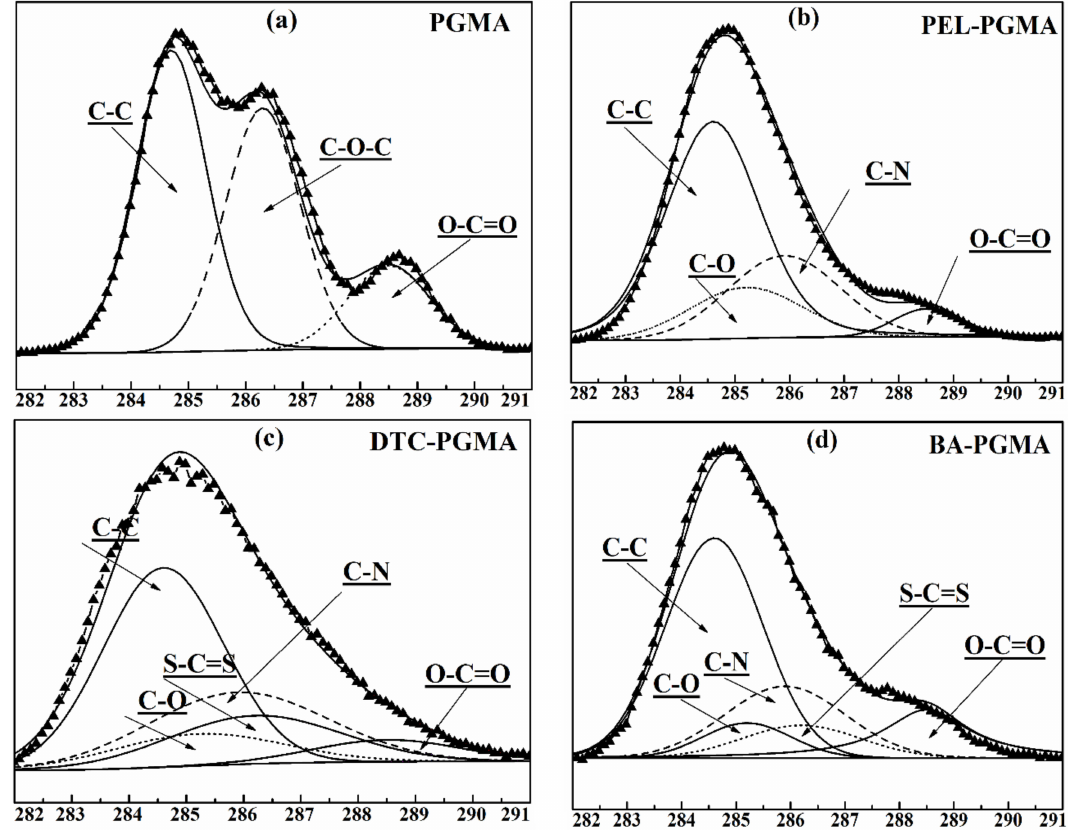
Figure 3. C1s spectra of PGMA ( a ), PEL-PGMA ( b ), DTC-PGMA ( c ), BA-PGMA ( d